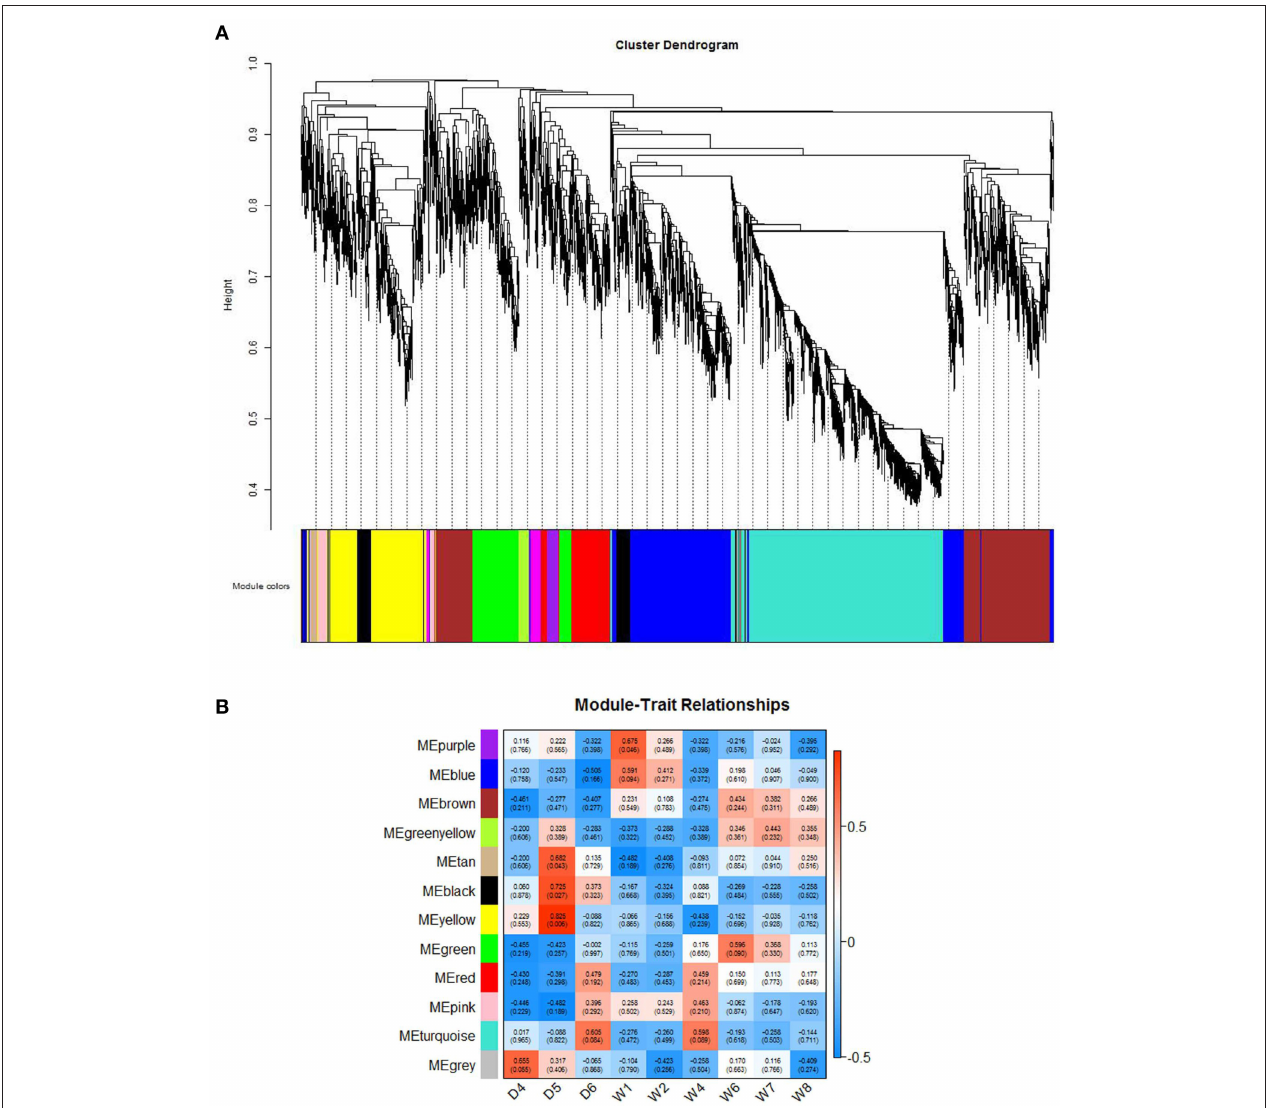
FIGURE 4 | Network analysis of sheep fecundity. (A) A hierarchical cluster tree showing the co-expression modules identified using the WGCNA. The modules correspond to the branches and are denoted by colors. (B) Heatmap reporting the correlations and the corresponding p -values between the modules and the sheep groups. The rows indicate the reported modules, and the columns represent the different sheep groups. The color indicates the level of correlation between the gene co-expression in the sheep